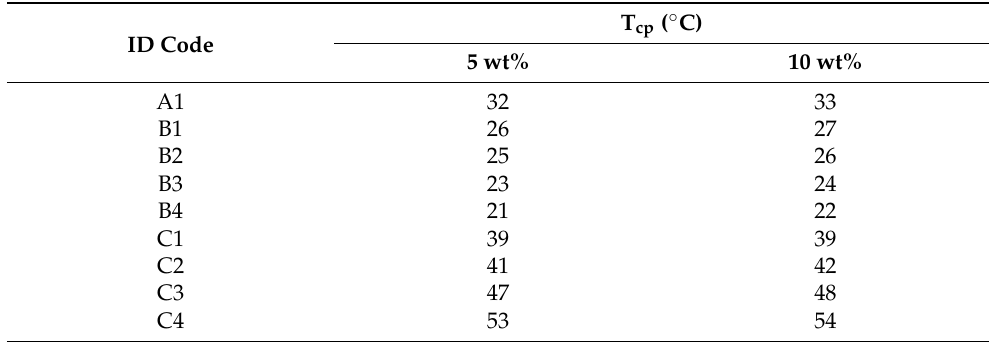
Table 4. T cp ( ◦ C) results of PNVCL, PNVCL/Vac, and PNVCL/NVP aqueous polymer